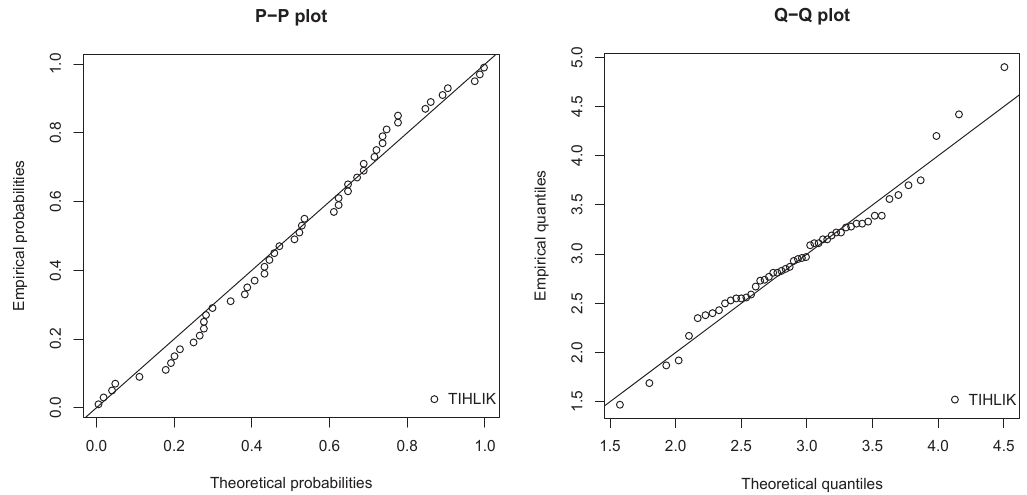
Figure 12. P–P plot and Q–Q plot of the estimated TIHLIK model for data set